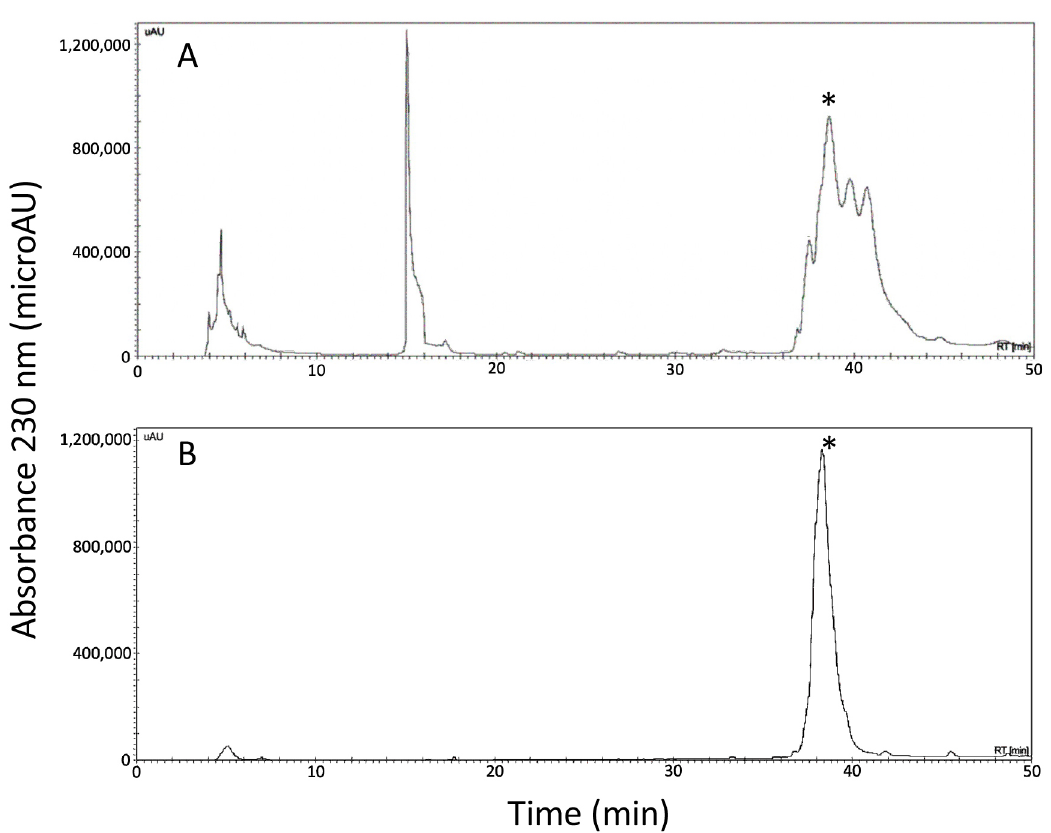
Figure 1. RP-HPLC separation of HisrAcra4 (A) by affinity chromatography and (B) after re-purification. (A) The recombinant protein HisrAcra4 was purified by affinity chromatography elution by applying RP-HPLC using an analytical C reversed-phase column (Vydac 214 TP 4.6 x 250 mm, Hesperia, CA, USA) with 18 a linear gradient using solvent A (0.1% trifluoroacetic acid, TFA, in water) and solvent B (0.1% TFA in acetonitrile). The linear gradient was from 0 to 60 % of solvent B over 60 min at 1 mL/min flow rate, with UV detection at 230 nm. (B) The re-purification step used similar RP-HPLC conditions as in A). The asterisk shows the fraction which presented lethal